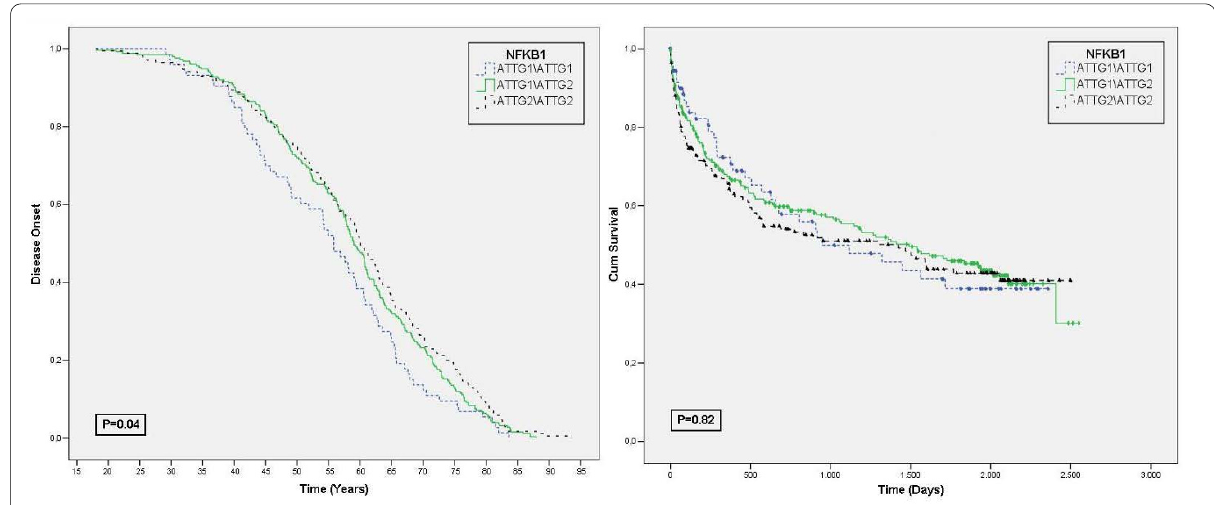
Figure 1 A Kaplan-Meier curve for Disease Onset (A) and Mortality (B) . Blue line represents genotype ATTG 1 /ATGG 1 , Green line genotype ATTG 1 / ATTG 2 and black line genotype ATTG 2 /ATTG 2 . In B, the different forms represent the event death for each